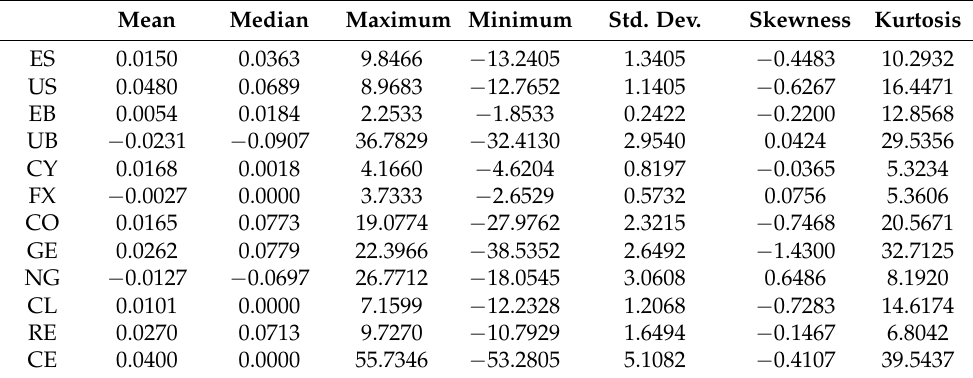
Table 1. Descriptive Statistics of the Studied